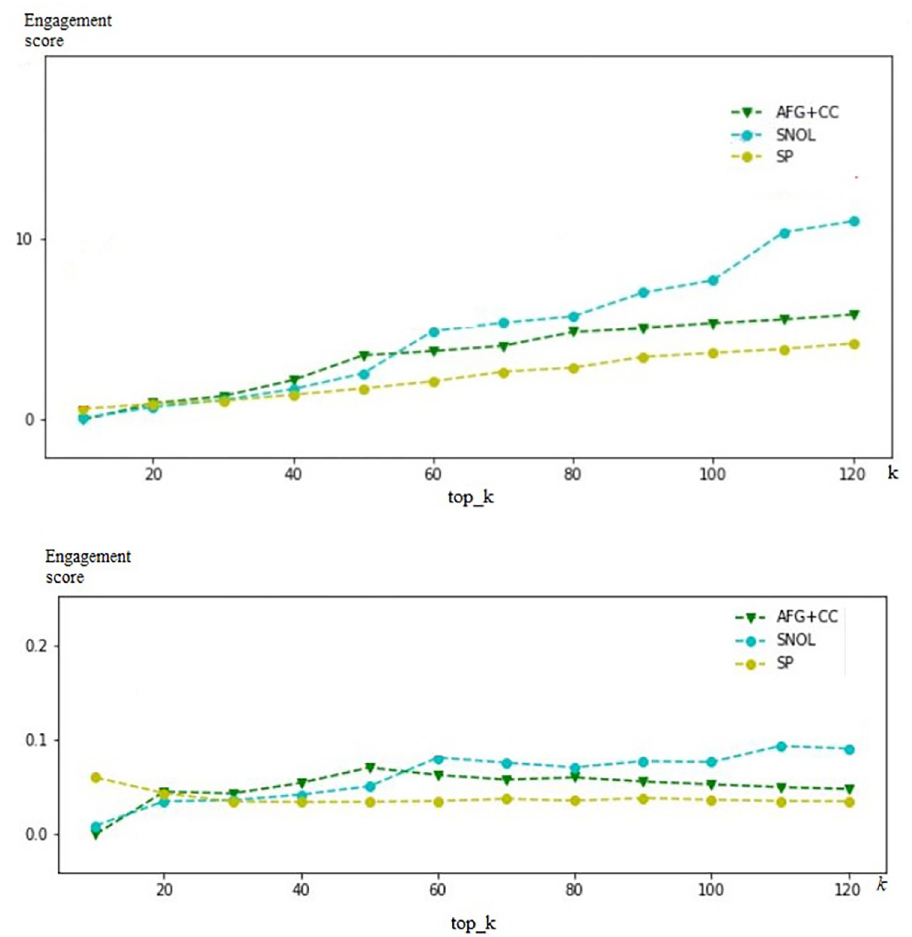
Fig 5. Comparing the engagement score of users using AFG+CC, SNOL and SP approaches. a. Total of engagement scores of users in top_k. b. The average of engagement score of users in top_k.